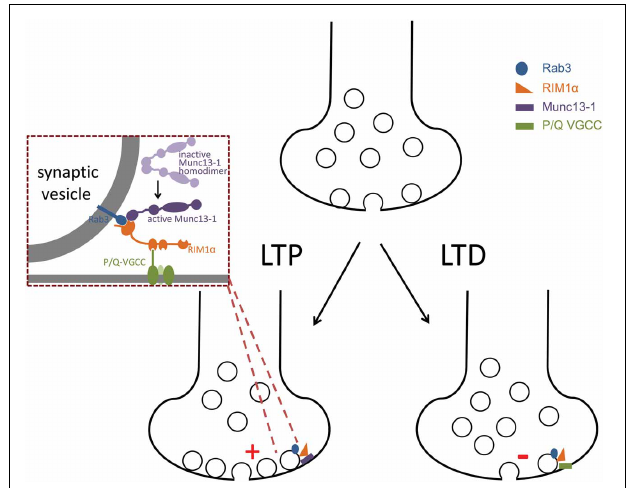
FIGURE 2 | Working models of expression mechanisms for presynaptic LTP and LTD. In this schematic, presynaptic molecules implicated in the expression of changes in presynaptic release probability associated with LTP and LTD are shown. In LTP at mossy fiber synapses, the specific interaction of RIM1a with Munc13-1 that promotes activation of Munc13 for vesicle priming is required, indicating that a likely cellular mechanism for increasing release probability may be through changes in the number of primed vesicles (indicated by vesicles adjacent to the terminal membrane). In LTD at hippocampal mossy fiber—stratum lucidum interneuron synapses and the nucleus accumbens, inhibition of P/Q type voltage-gated calcium channel (VGCC) activity is associated with expression of LTD. Whether this modulation of channel activity requires interaction with RIM1a has not been tested. At other synapses, a requirement for Rab3 and RIM1a for LTD has been described. Therefore, in the LTD working model, we also hypothesize that LTD mechanisms opposite to LTP may occur and thus show fewer primed vesicles to lead to a decrease in release probability. However, a requirement for Munc13 in LTD has not yet been tested. In addition, while Rab3a and RIM1a are both implicated in LTP and LTD, whether their interaction is required has also not been tested. Lastly, whether multiple expression mechanisms co-exist within a synapse or occur at distinct subsets of synapses remains to be